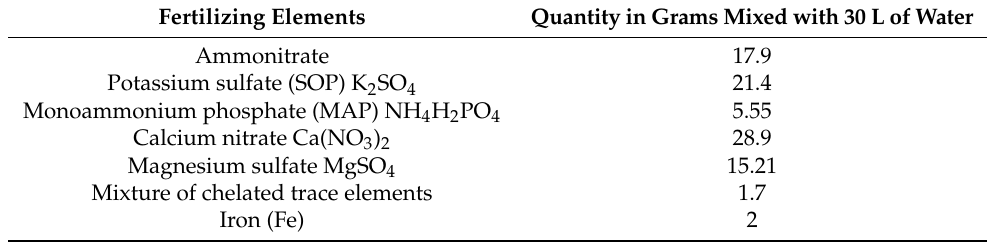
Table 2. Chemical composition of the nutrient solution (Steiner 60%) applied to tomato plants during the